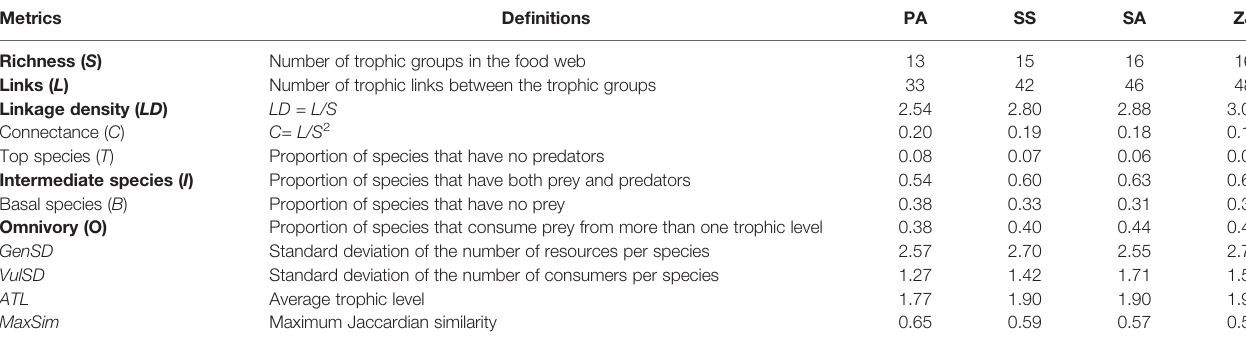
TABLE 1 | Topological properties of the food webs in the Phragmites australis (PA), Suaeda salsa (SS), Spartina alterni fl ora (SA), and Zostera japonica seagrass (ZJ) habitats along the coastal topographic gradient in the Yellow River Delta. Metrics De fi nitions